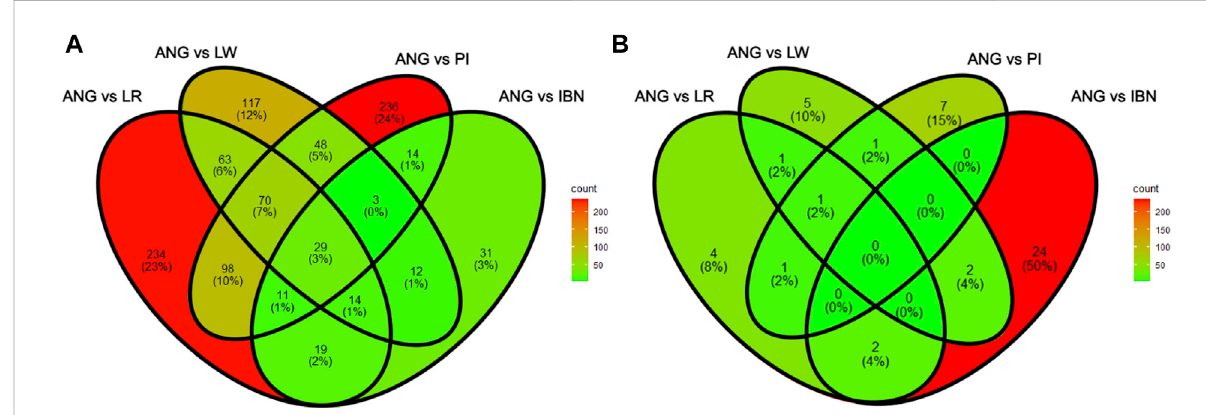
TABLE 3 Quantitative trait loci related to common genes found in xp F ST / θ π and xpEHH analysis. Gene QTL ID Description Breed comparison Ref NRCAM — — ANG vs . IBN, ANG vs . LW — SNX24 — — ANG vs . IBN — RBFOX1 — ANG vs . IBN — ANG vs . IBN — SNTG1 — — ANG vs . PI, ANG vs . LR — CDKAL1 — — ANG vs . PI, ANG — LW, ANG vs . DU DOCK5 31226 Backfat between 3rd and 4th last ribs ANG vs . LR Fowler et al. (2013) DLGAP2 22424 Feed intake per feeding ANG vs .